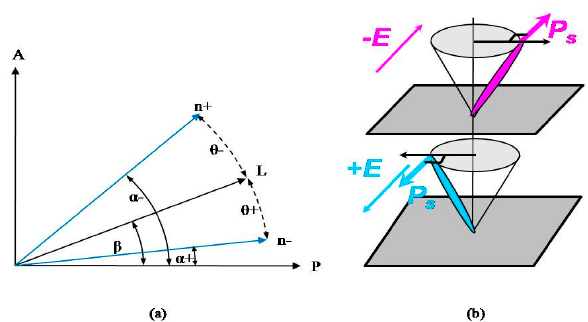
( b ) Figure 2. ( a ) Schematic of the wedge shaped cell and ( b ) graph showing the wavelength dependent transmittance of cells of different thicknesses. The wedge cell was placed on a hot stage under crossed polarized states and the light transmission through the cell was measured using an Avaspec spectrometer, which provides accuracy of wavelength better than 10%. The empty cell thickness (Figure 2b) was measured from the interference fringes reflected from both glass substrates, and is calculated as )(2/ knknkk nd λλλλ −= ++